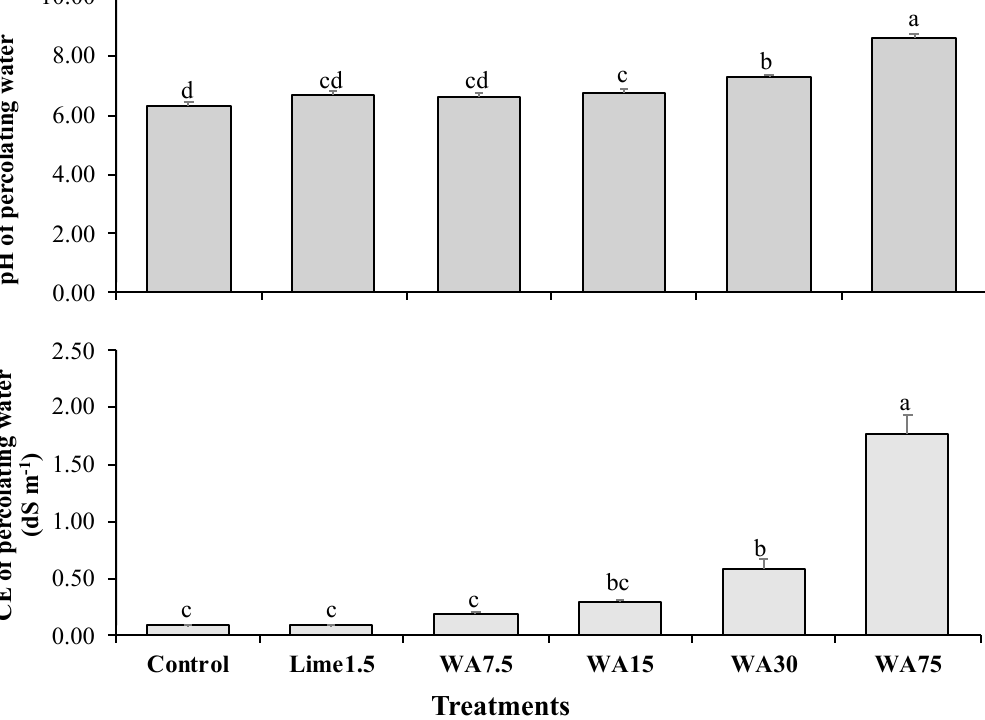
Figure 1. Effect of commercial lime and wood ash on pH and CE of percolating water. Lime1.5, commercial lime at 1.5 g kg − 1 ; WA7.5, WA15, WA30 and WA75, wood ash at 7.5, 15, 30 and 75 g kg − 1 ,